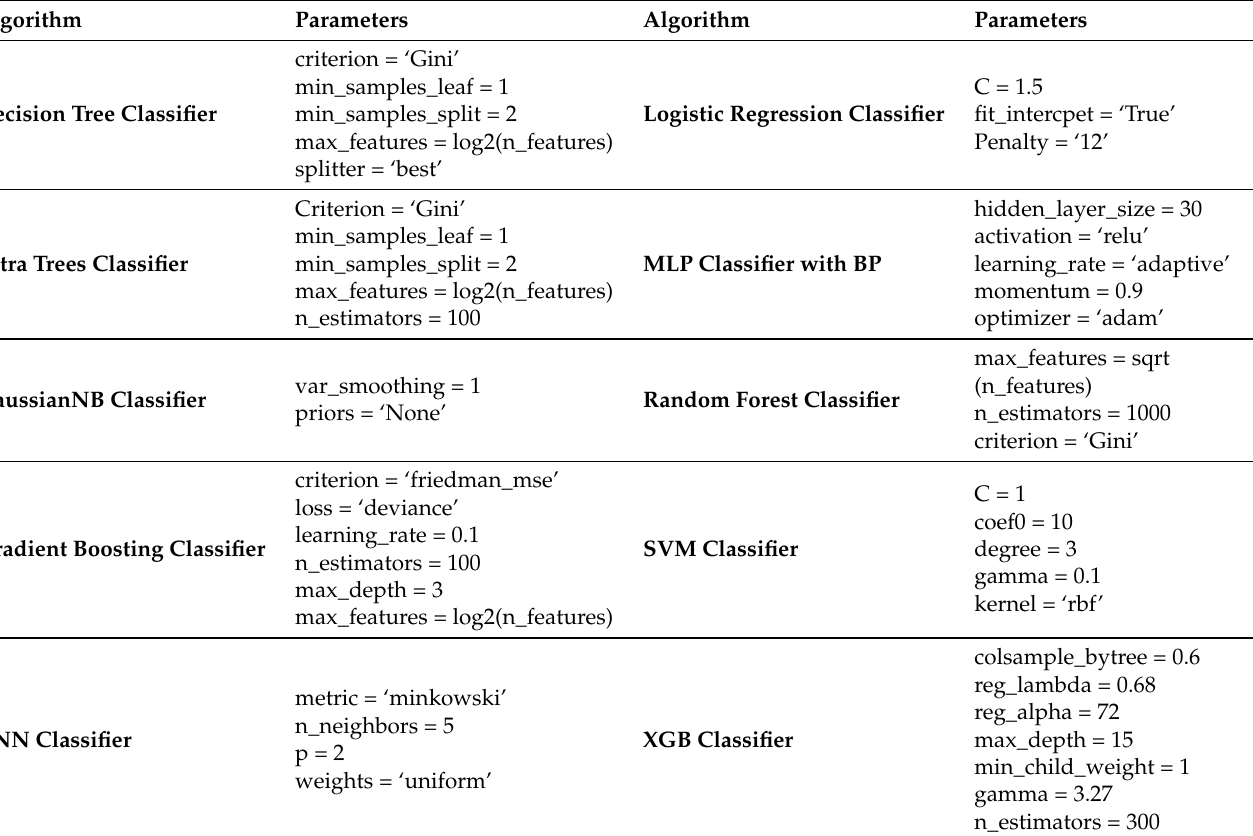
Table A1. Model hyperparameters and their optimal